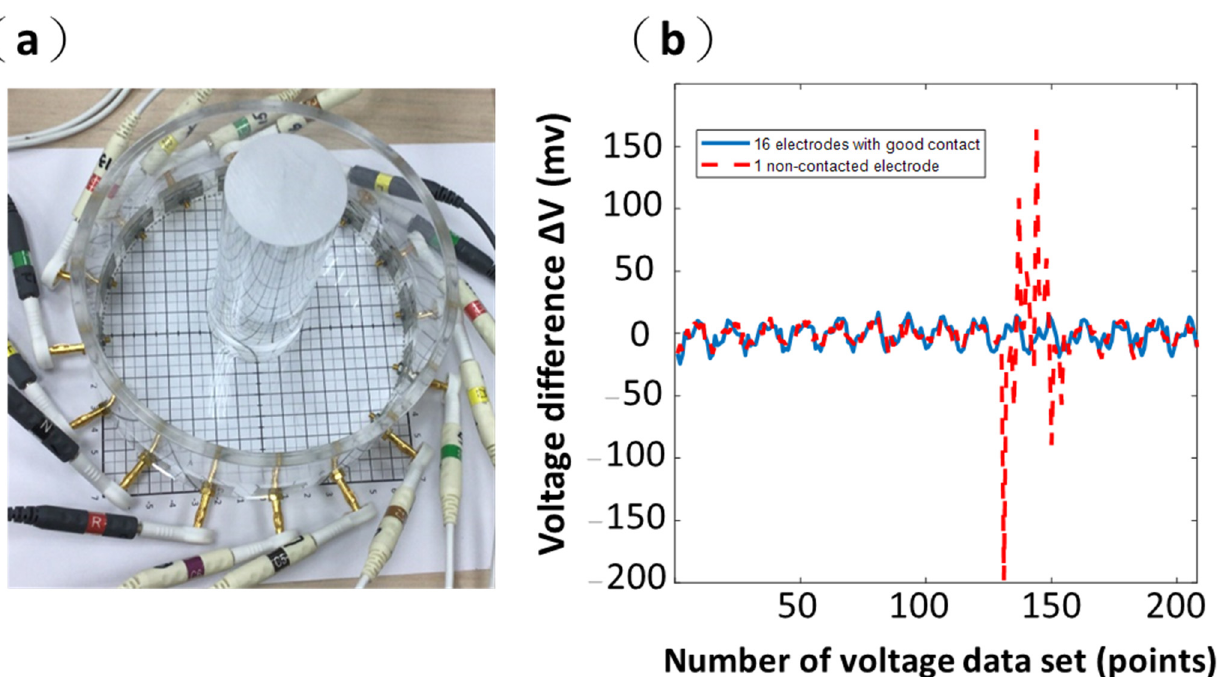
Figure 5. A saline tank is used to calculate the voltage difference ∆ V. ( a ) A saline tank with an acrylic rod. ( b ) The voltage difference ∆ V with all 16 electrodes having a good contact and 1 non-contacted electrode.